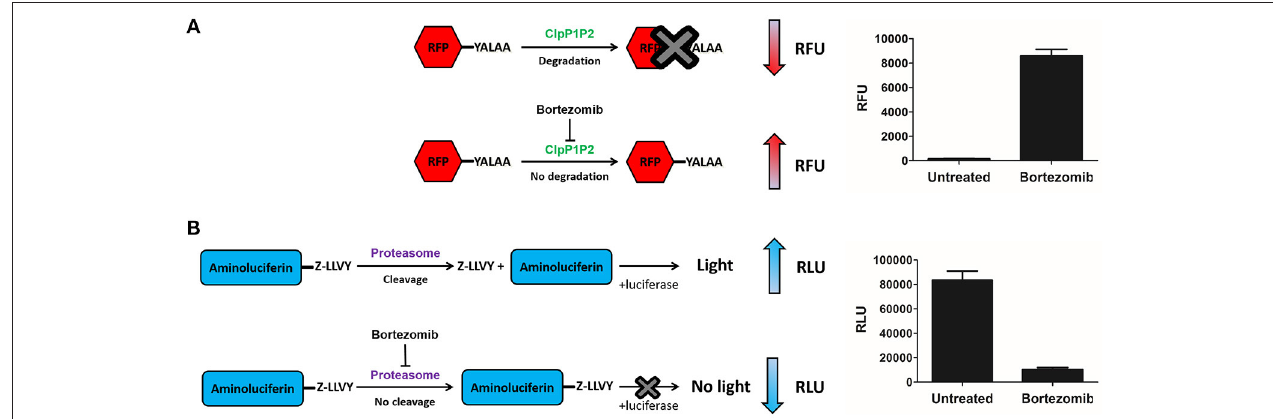
FIGURE 1 | ClpP1P2 and proteasome inhibition assays. (A) ClpP1P2 inhibition assay principle. Under undisturbed conditions, ClpP1P2 recognizes and degrades SsrA-tagged (YALAA) RFP protein resulting in a low fluorescence level. In the presence of a ClpP1P2 inhibitor like Bortezomib, RFP is not degraded. Its accumulation results in an increase in fluorescence. (B) Proteasome inhibition assay principle. Under undisturbed conditions, the proteasome recognizes the Z-LLVY tag and cleaves it. The aminoluciferin is used as a substrate by the luciferase enzyme to generate luminescence. In the presence of a proteasome inhibitor like Bortezomib, the cleavage of Z-LLVY is prevented. The lack of luciferase substrate results in a reduced luminescence emission. RFU, relative fluorescence unit; RLU, relative luminescence unit.